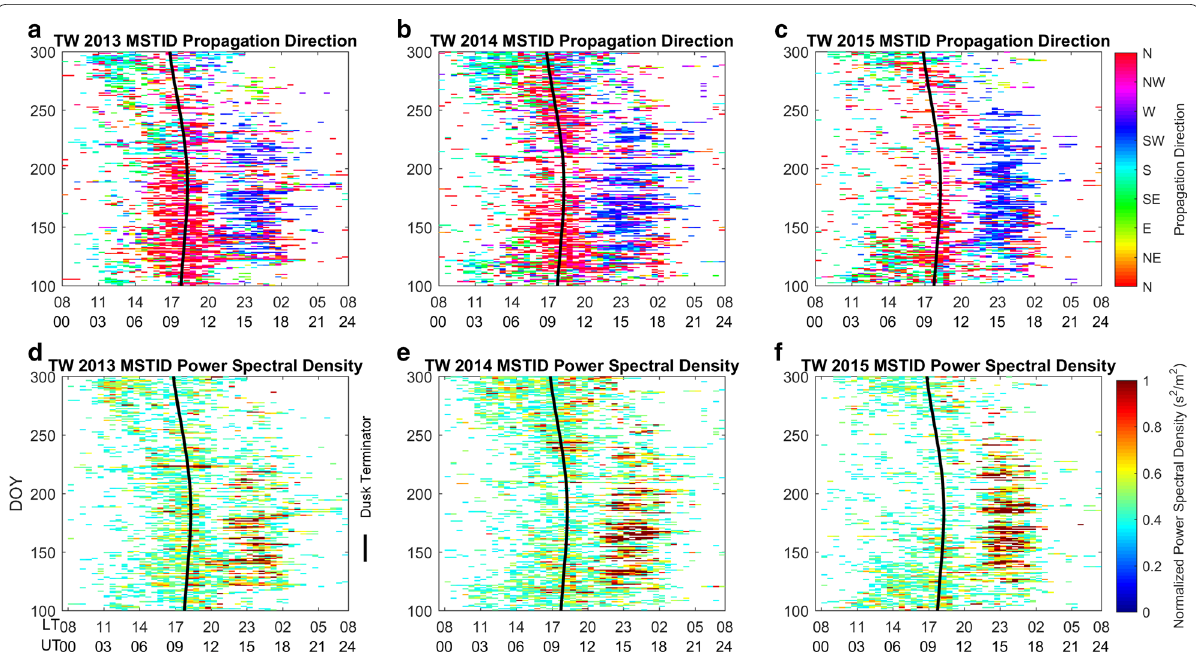
Fig. 6 A comparison between propagation direction and normalized PSD of MSTIDs with a dusk terminator (black line) over Taiwan. The southwestward MSTIDs (deep blue color) in the years a 2013, b 2014, c 2015 is in good agreement with the PSD with greater value (red color) in d 2013, e 2014, f 2015, suggesting that the southwestward MSTIDs have greater amplitudes than those propagating in other